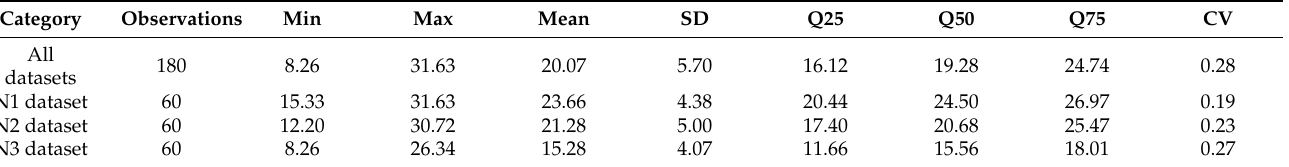
Table 4. Statistics on the characteristics of TNC in samples from each plot at the heading stage (mg · g − 1